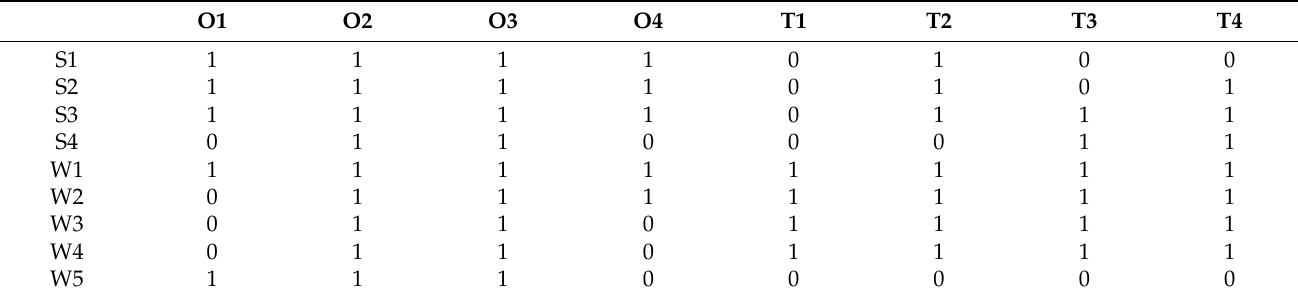
Table A1. SWOT relationships between factors used in the analysis.